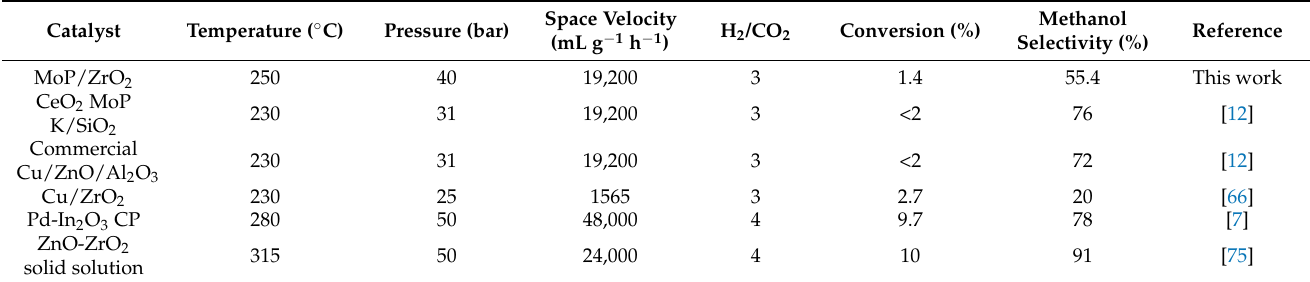
Table 1. Comparative performance of MoP/ZrO 2 with other reported catalysts for methanol synthesis from CO 2 .